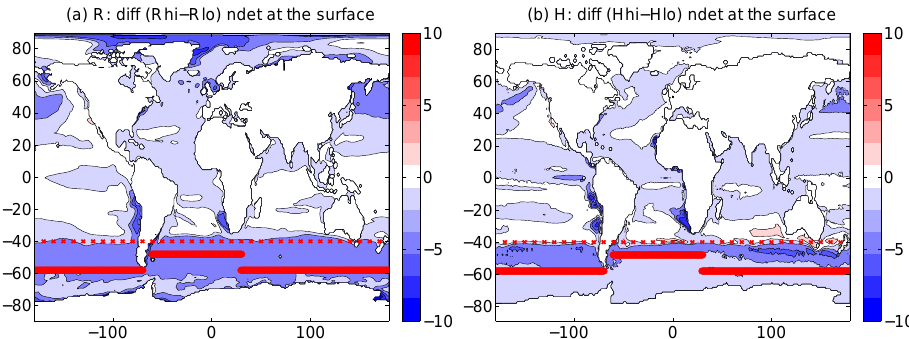
Fig. 3. Surface distributions of δ Detritus in (a) the GISSER (shorthand: R) and (b) the GISSEH (shorthand: H) models at equilibrium. δ detritus is defined as the difference between detritus in the high (hi) and the low (lo) remineralization cases. Units are mg Cm − 3 . The STCZ is denoted with the crossed line at 40 ◦ S and the SAF is denoted with the continuous red line, at about 48 ◦ S in the Atlantic Ocean and at 58 ◦ S in the Indian and the Pacific Oceans. In the Southern Ocean, the GISSEH model shows the largest detritus reduction in the region that lies between the Antarctic Polar Front (APF) at about 50 ◦ S and the STCZ ( ≈ 40 ◦ S, Fig. 265 3). Similar reductions are shown in the GISSER model but over a wider region (70 ◦ S - 40 ◦ S). The reduction region in GISSEH is narrower than in GISSER, because the former model has significantly shallower mixed layer depths in the region 70 ◦ S-50 ◦ S since the temperature there is much higher than in GISSER (see Fig. 3 in Romanou et al. (2013)). Higher temperatures in GISSEH lead to